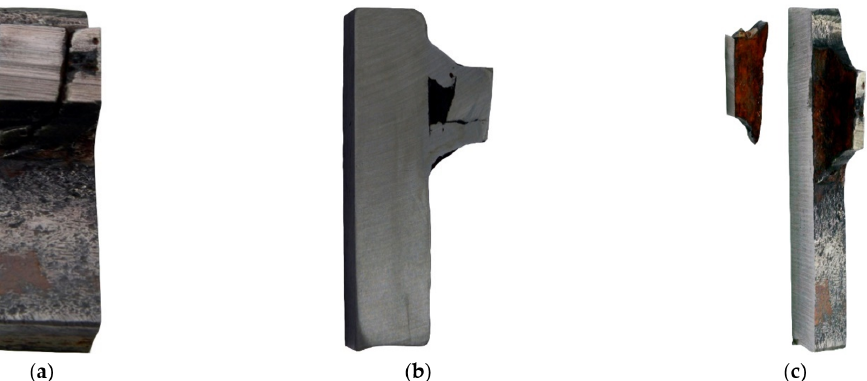
Figure 13. A macroscopic examination of crack 1 (handy-size bulk carrier 30206 DWT): ( a ) the bar cut from elements I and II, containing crack 1; ( b ) the joint between elements I and II and ( c ) the exit of crack